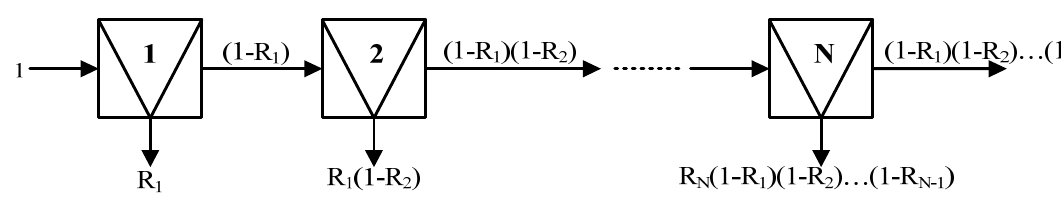
Figure 5. Flotation bank composed of N